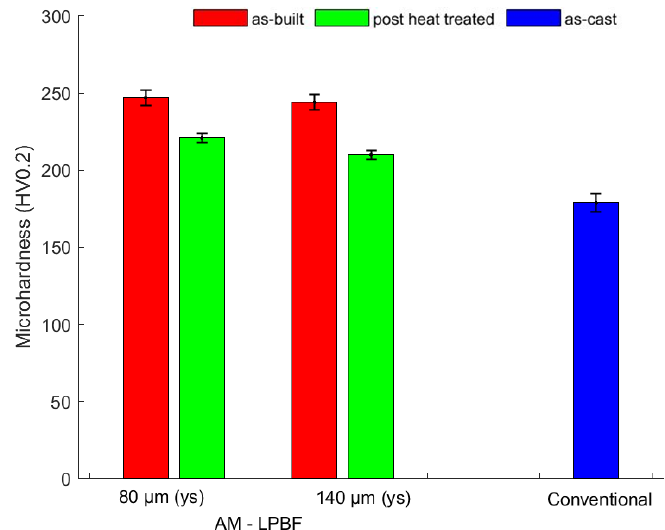
Figure 9. Microhardness of as-built, post heat treated (PHT), and as-cast material compared. Table 3. Comparison of microhardness of as-cast, as-built, and as-built + PHT cubes. Material: G-NiCu30Nb HV 0.2